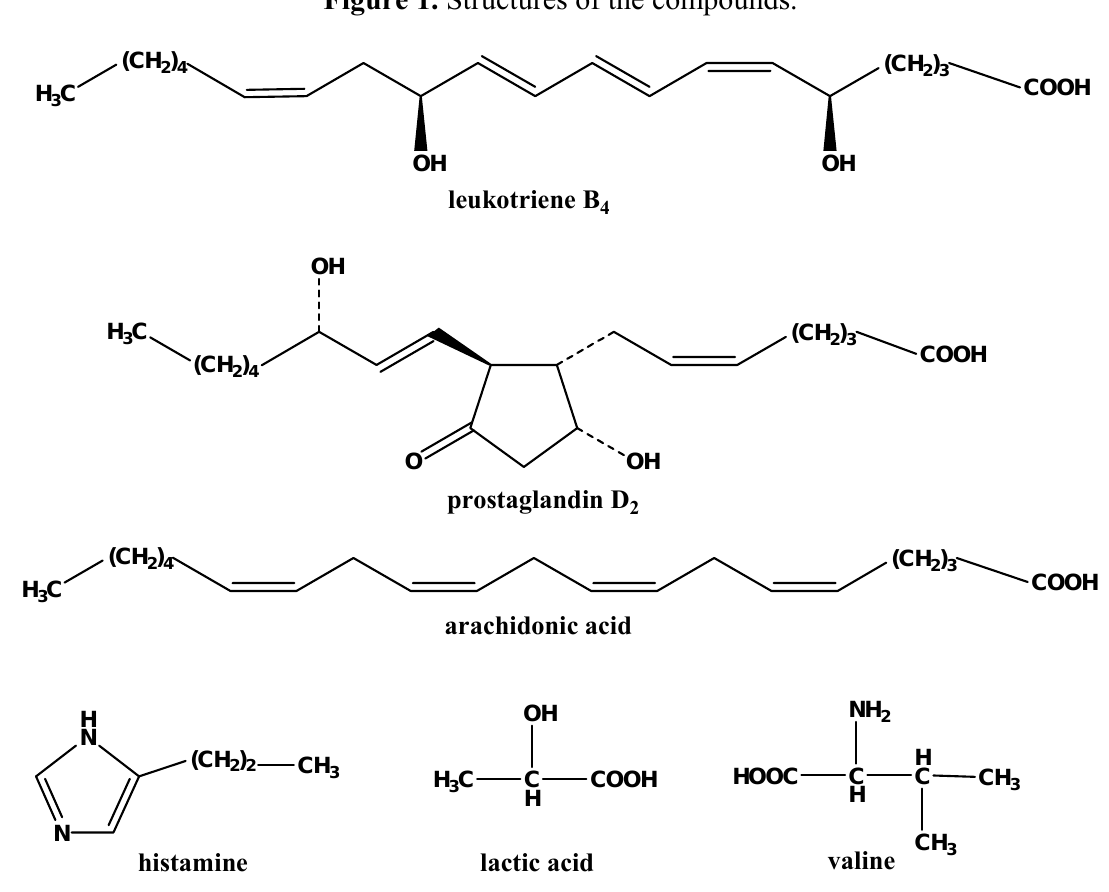
Figure 1. Structures of the